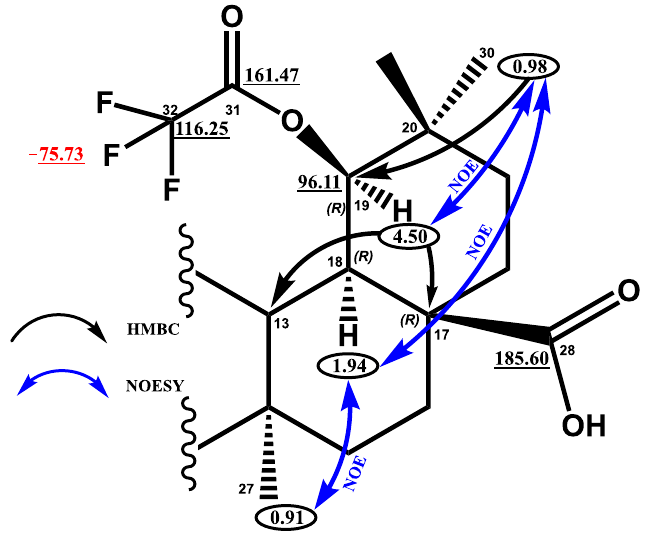
Figure 1. HMBC and NOESY correlations of compound 3 .